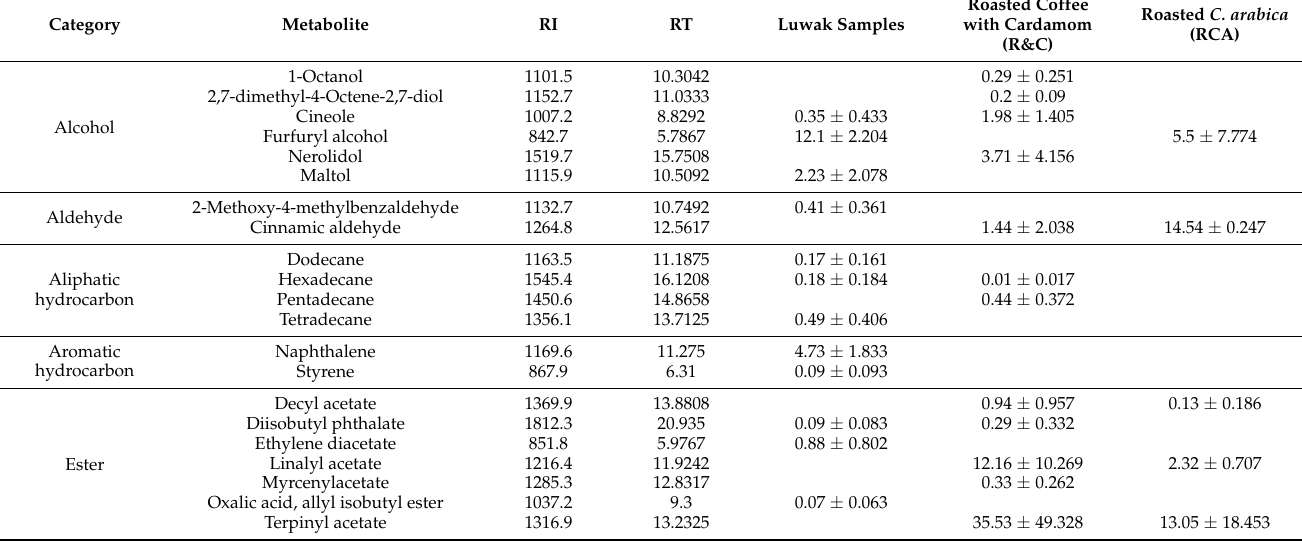
Table 3. The volatiles detected using SPME/GC-MS in Luwak coffee, alongside roasted coffee (RCA) and roasted coffee with cardamom, expressed as a relative percentile (mean ±